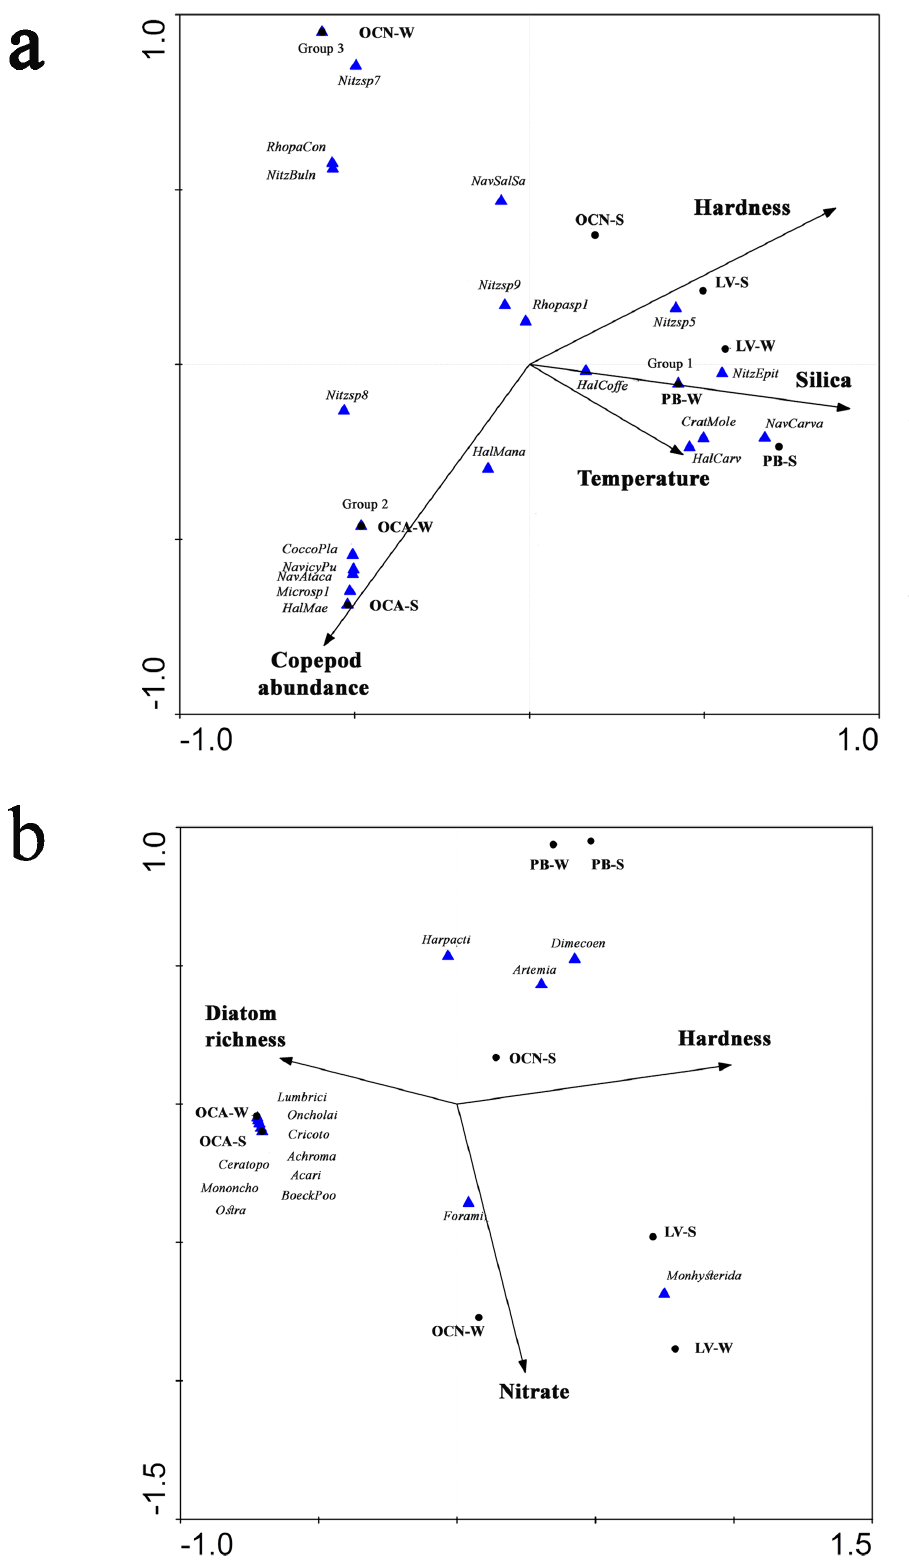
Figure 5. Canonical Correspondence